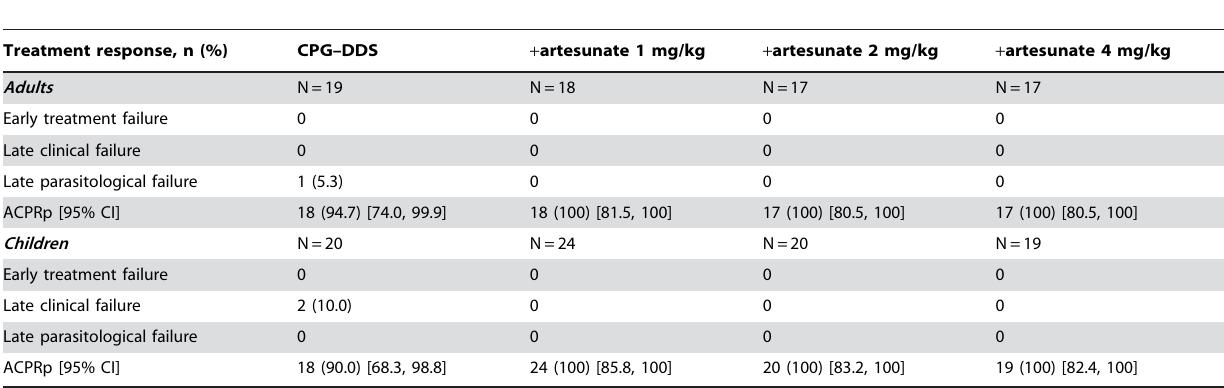
Table 4. Treatment responses at Day 14 based on WHO 2002 definitions [20] (Day 14 per-protocol population).